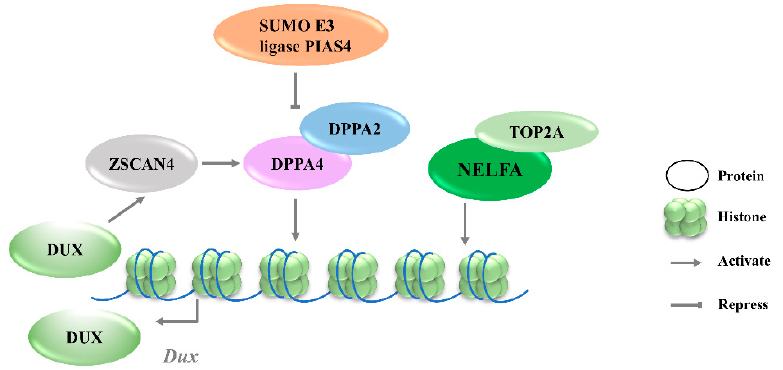
Figure 1. Transcriptional regulation of Dux expression by transcription factors. DPPA2/4 and NELFA transcriptionally activate Dux. Meanwhile, DUX can activate Zscan4 which will upregulate DPPA2/4. PIAS4 will repress DPPA2/4 expression through the SUMOylating of DPPA2. DPPA2/4, developmental pluripotency associated 2/4; PIAS4, protein inhibitor of activated STAT 4; NELFA, negative elongation factor complex member A; ZSCAN4, SCAN domain containing 4; TOP2A, DNA topoisomerase 2a; DUX, double homeobox.